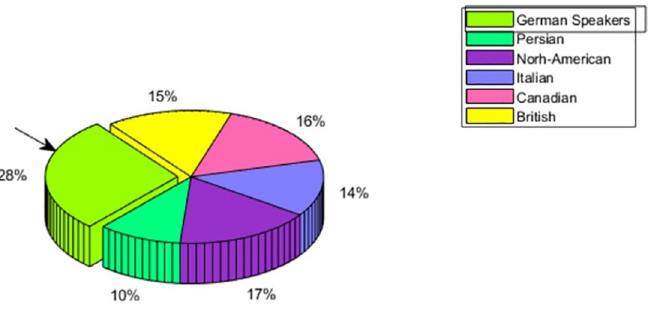
Fig 7. German speaker—Multicultural emotion accuracy comparison and In-group advantage.